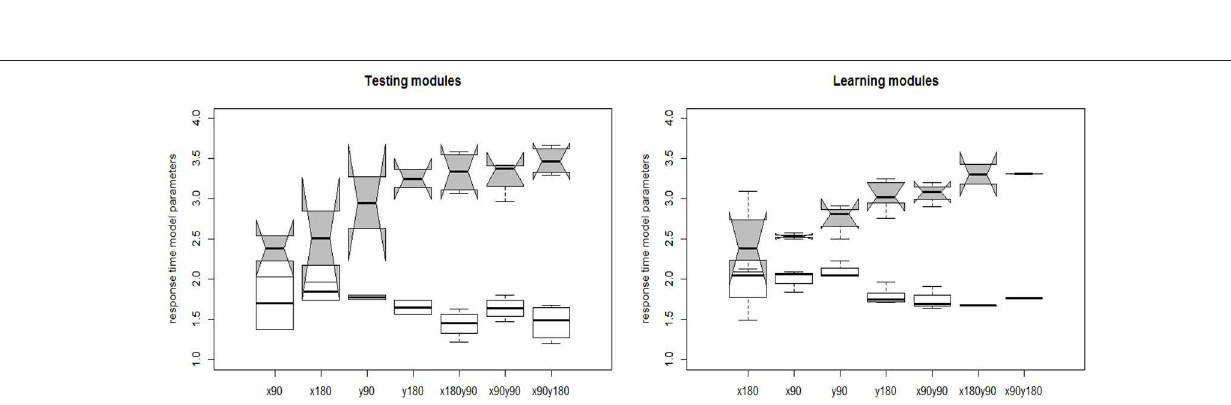
FIGURE 8 | The estimated response time model item parameters. The white whisker diagram represents the time discrimination parameter a and the gray ones represent the time intensity parameters γ .